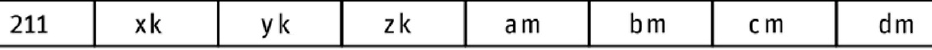
Figure 7. Extended measurement data frame.